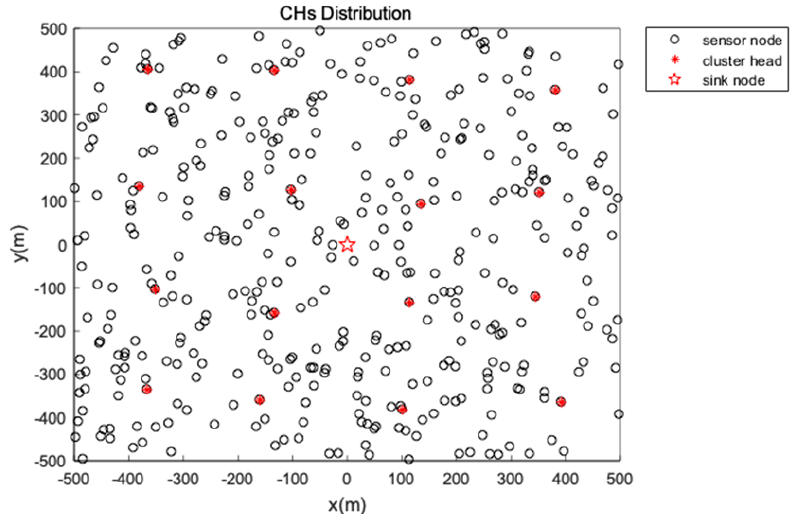
Figure 4. First period CHs distribution.